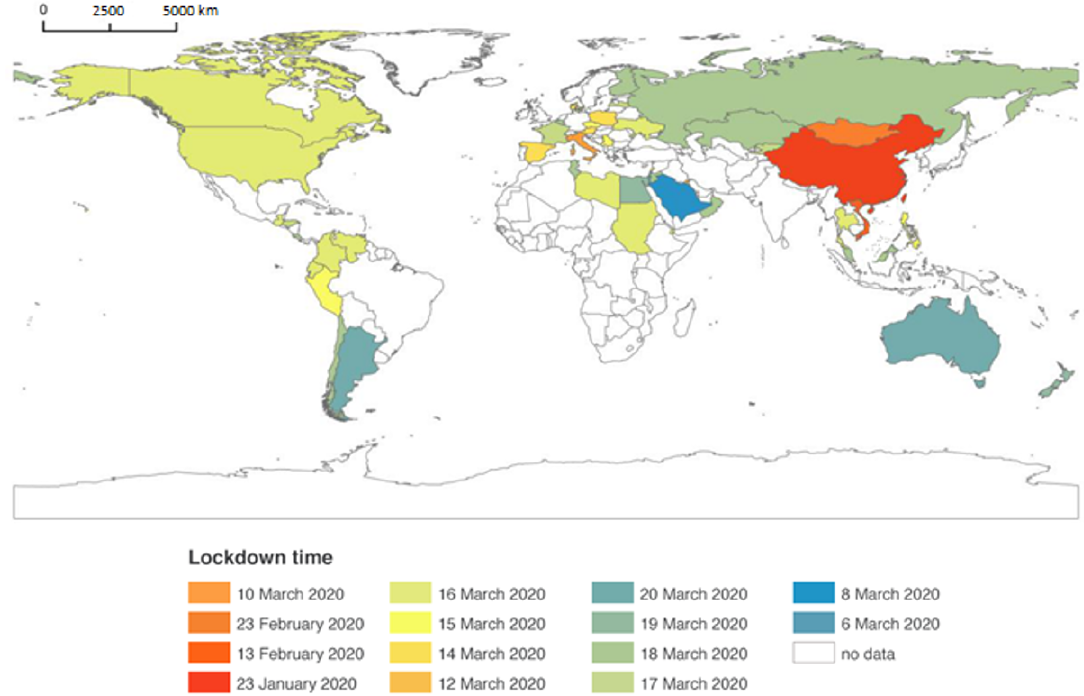
Figure 1. Lockdown policies worldwide by date and country (resources shown in Supplementary